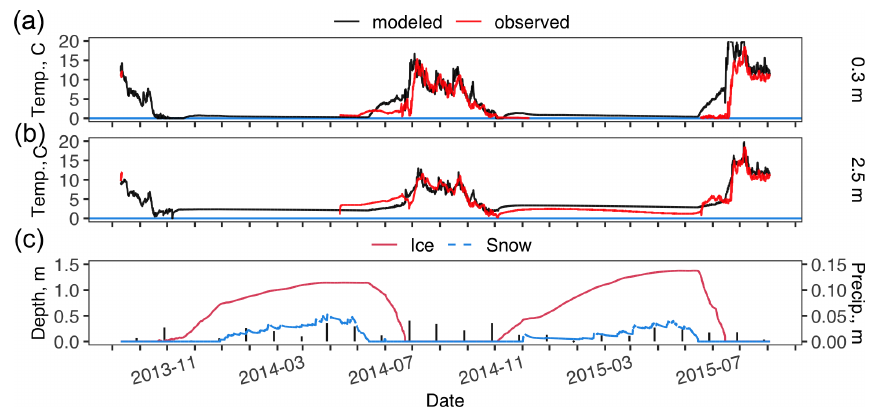
Figure 1. Atqasuk modeled and observed lake water temperature at 0.3m (a) and 2.5m (b) and modeled lake ice depth, lake snow depth, and measured monthly precipitation (vertical black bars) (c) . Gray shading indicates periods of uncertainty in temperature sensor depth when ice-rafting may have moved the sensor to shallower water. The y axis of panel (a) is limited to water temperatures > 0 ◦ C as the LAKE model water temperature is limited to > 0 ◦ C. Table 2. LAKE model performance for Atqasuk, Fox Den, and Toolik Lake water temperatures. Mean absolute error (MAE), root-mean- squared error (RMSE), and bias for the total simulation period (annual), frozen, and thawed seasons. See methods for details. The frozen season was defined as days with ice thickness > 0 . 0m.